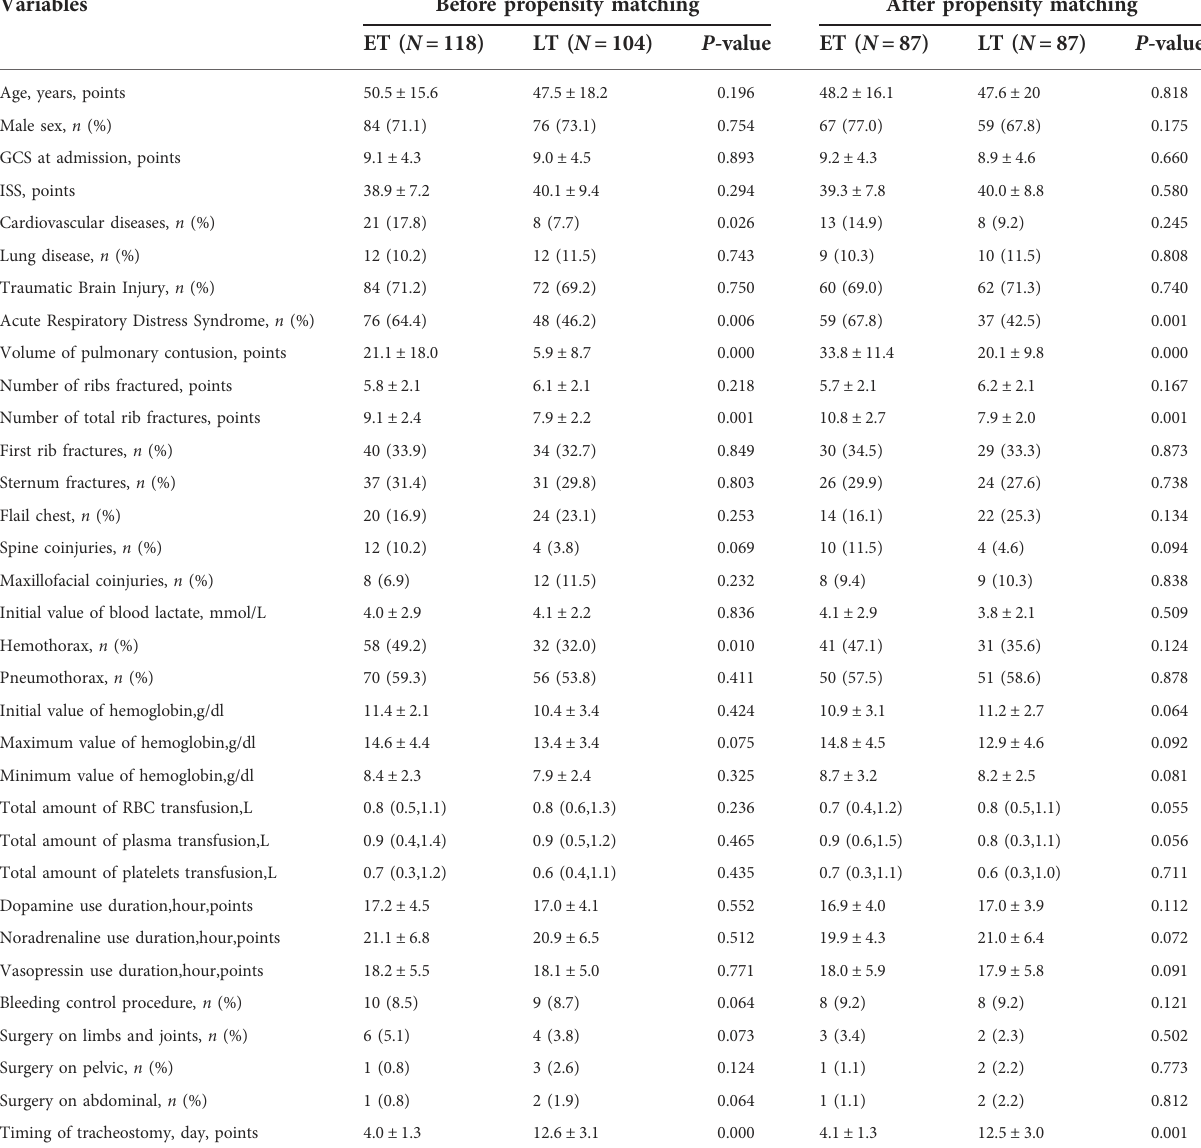
TABLE 1 Comparison of baseline data of patients before and after propensity score matching. Variables Before propensity